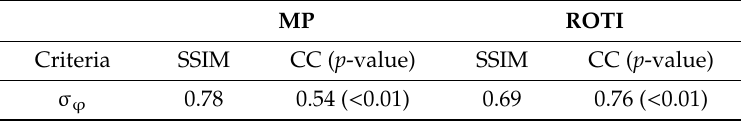
Table 13. SSIM and CC between the maps shown in Figure